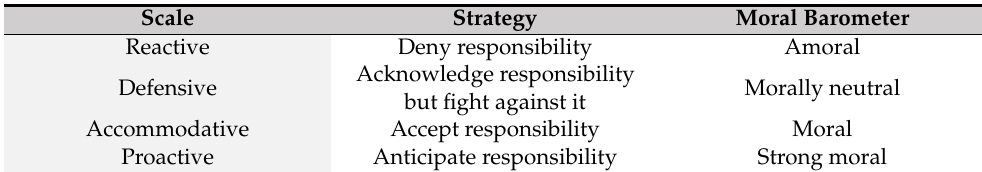
Table 1. RDAP scale table adapted from Clarkson (1995) including the strategy of the organization and enriched with the moral barometer by Aguilera et al. (2007). Scale Strategy Moral Barometer Reactive Deny responsibility Amoral Acknowledge responsibility Morally neutral Defensive but fight against it Accommodative Accept responsibility Moral Proactive Anticipate responsibility Strong moral